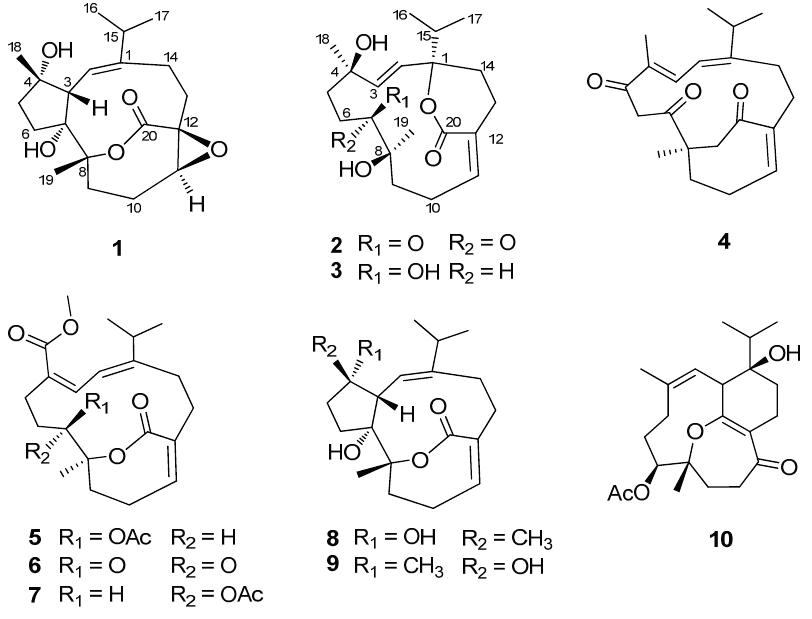
Figure 1. Compounds 1 – 10 isolated from Sarcophyton elegans